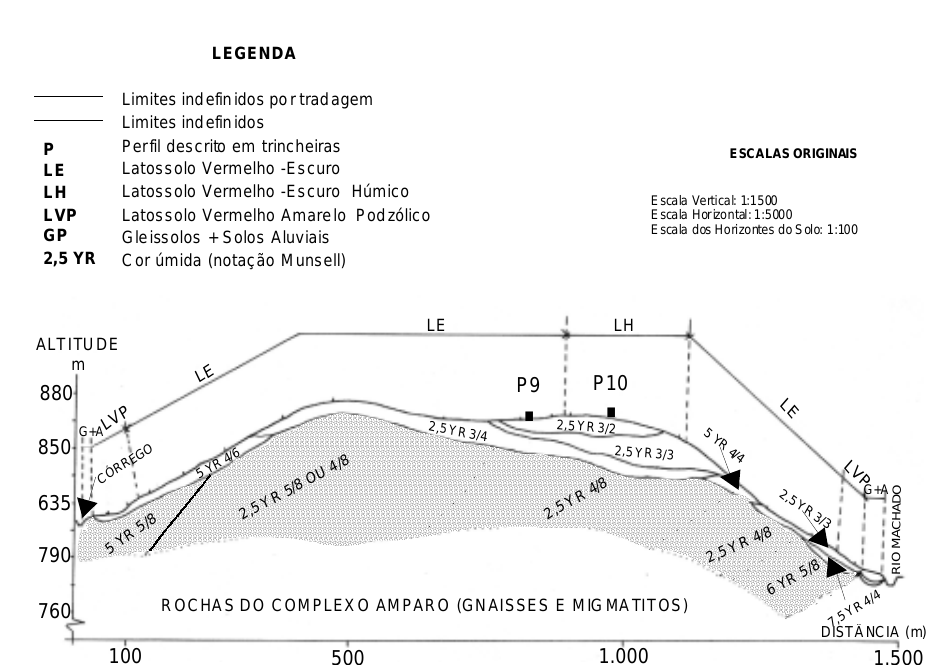
Figura 4. Sistema morfopedológico